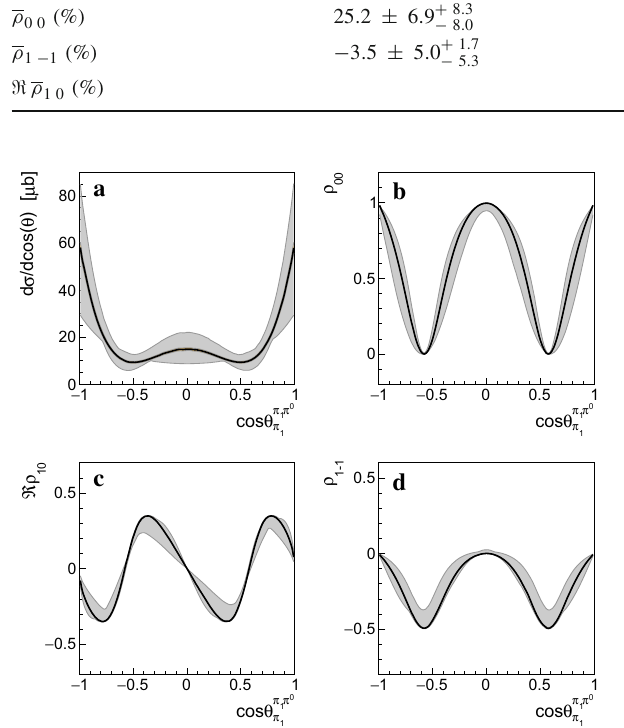
π 0 with Fig. 19 Differential production cross section of ¯ pp → π 0 1 π 0 → π 0 η ( a ) and spin density matrix elements ρ (cid:13) ρ 00 ( b ), 10 ( c ) and 1 ρ π 0 π 0 . All elements are shown in the in ¯ pp → π 0 1 − 1 ( d ) of the 1 1 helicity system of the π 0 . The yellow and the gray bands stand for the 1 statistical and systematic uncertainty,